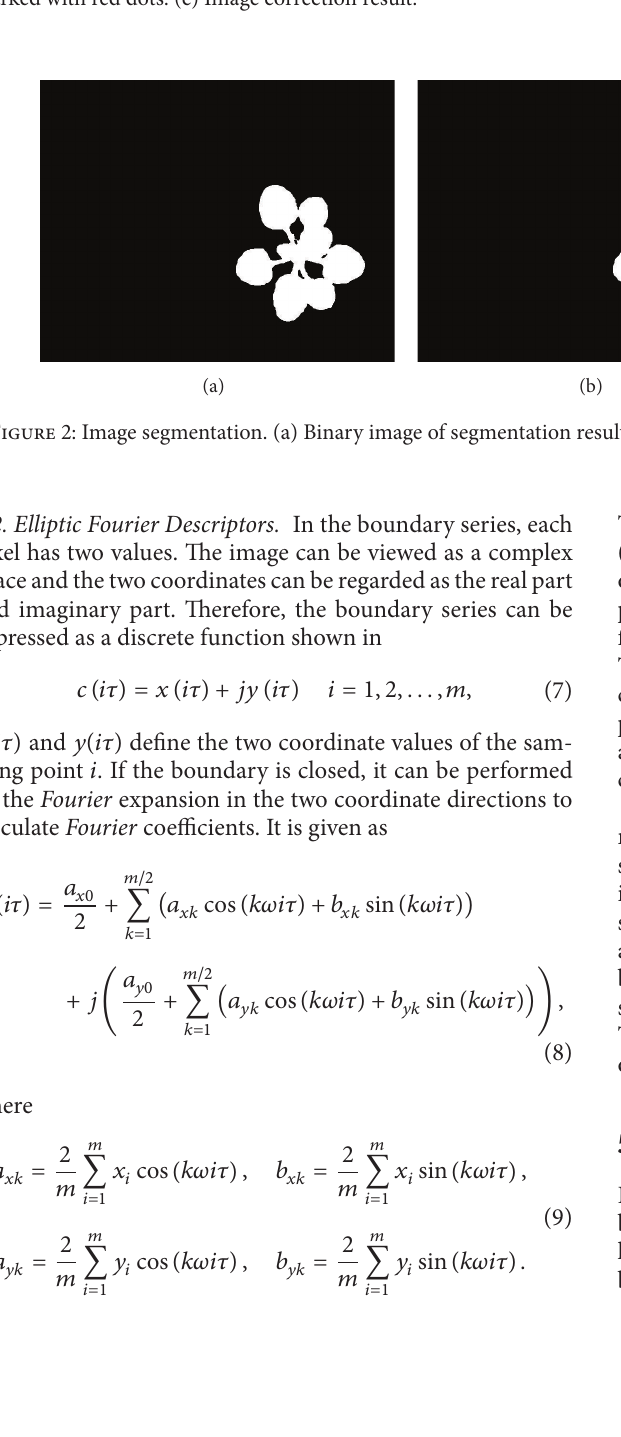
Figure 1: Image preprocessing. (a) Original image of an Arabidopsis plant, with soil background. (b) Corner detection result. The corners are marked with red dots. (c) Image correction result.